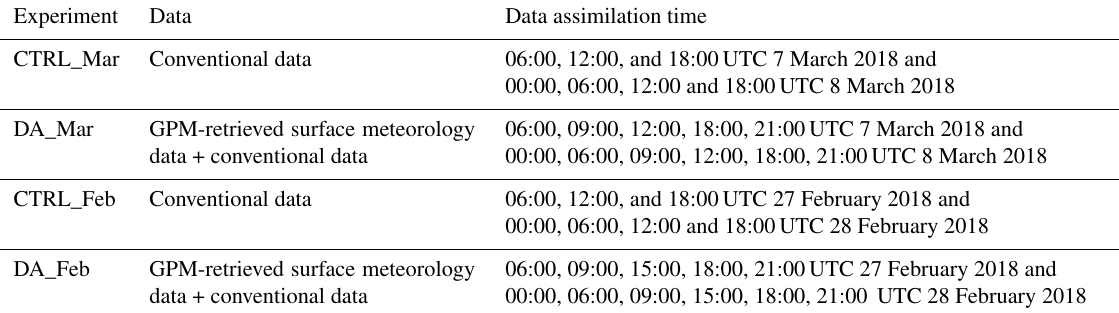
Table 1. Numerical experiment